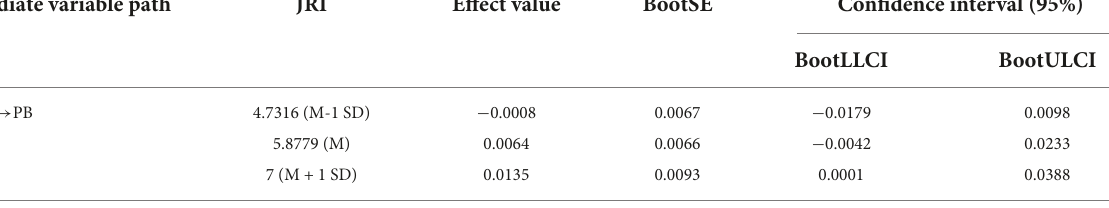
TABLE 7 Bootstrap analysis of the moderated mediating role (5,000